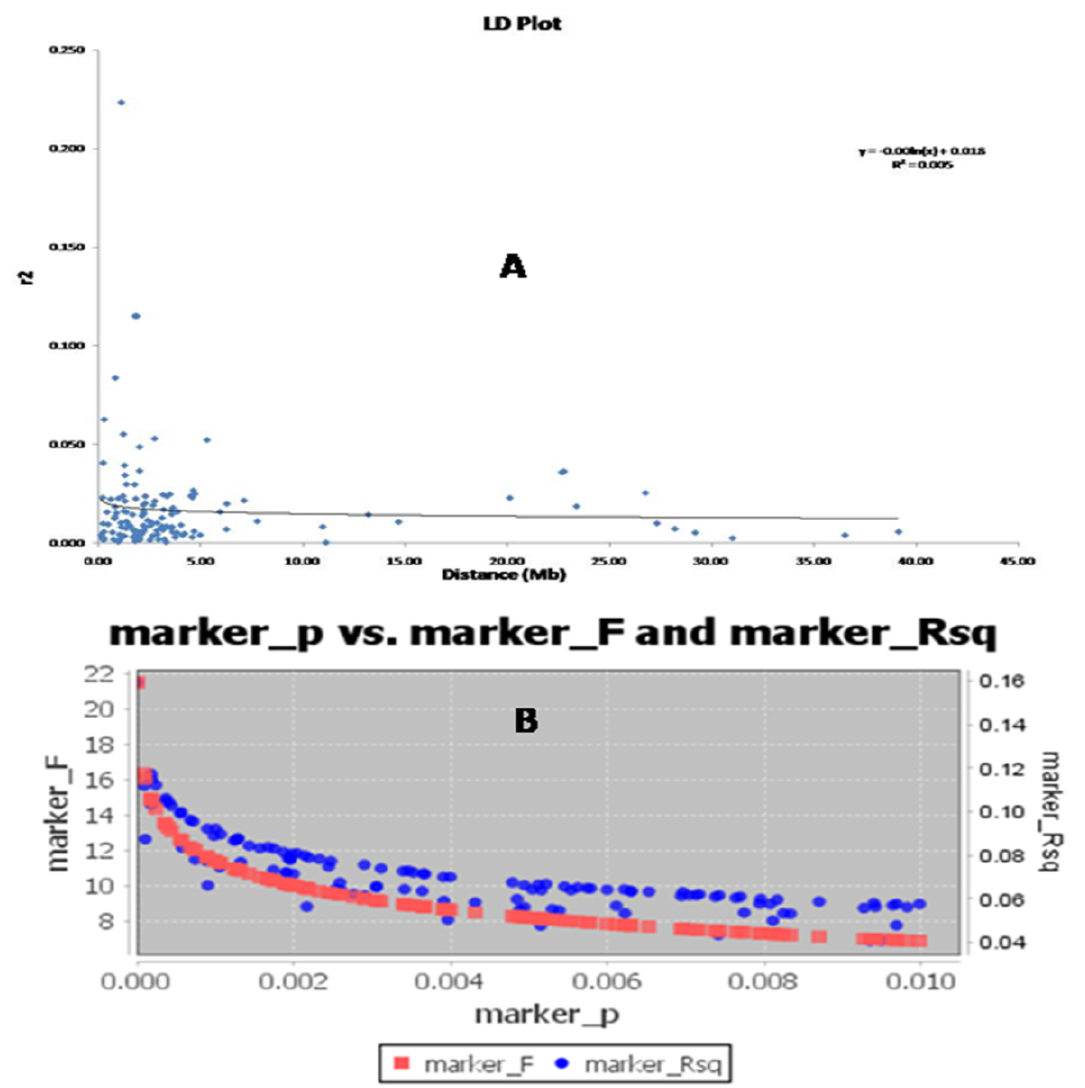
Figure 6. ( A ) The physical distance (base pairs, bp) between pairs of loci on chromosomes against linkage disequilibrium (LD) decay ( r 2 ) curve plotted in rice. The decay started in million bp estimated by taking the 95th percentile of the distribution of r 2 R2 for all unlinked loci. ( B ) The marker ‘P’ versus marker ‘F’ and marker R 2 .